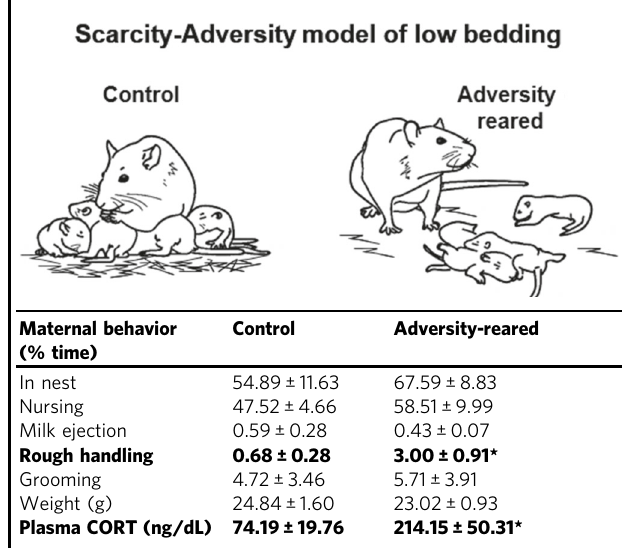
Table 1 Relative occurrence of maternal behaviors within adversity-reared vs. control-reared